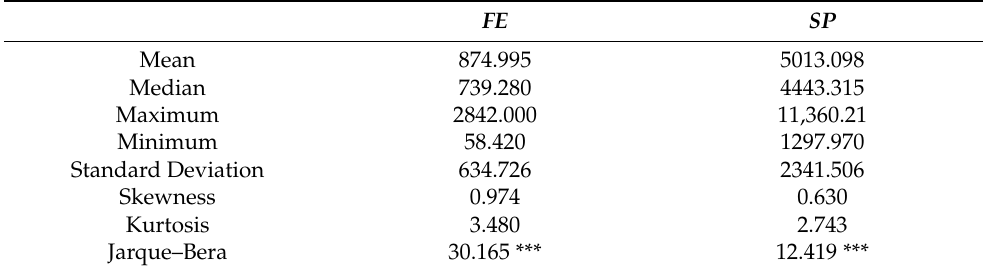
Table 1. Descriptive statistics for FE and SP .